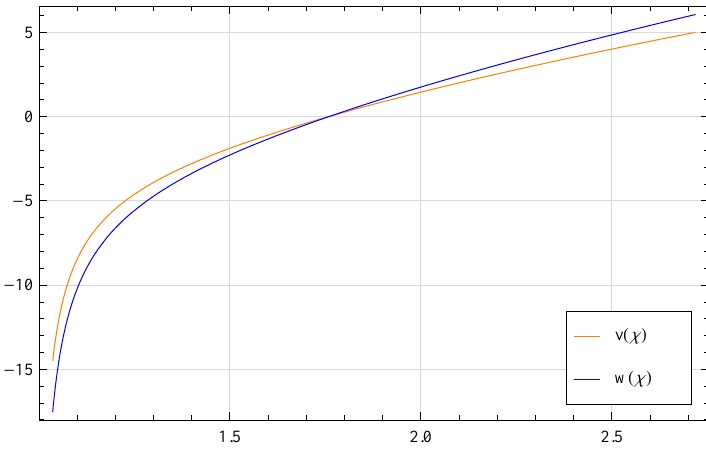
Figure 3. Sketch of solution in case (iii) .